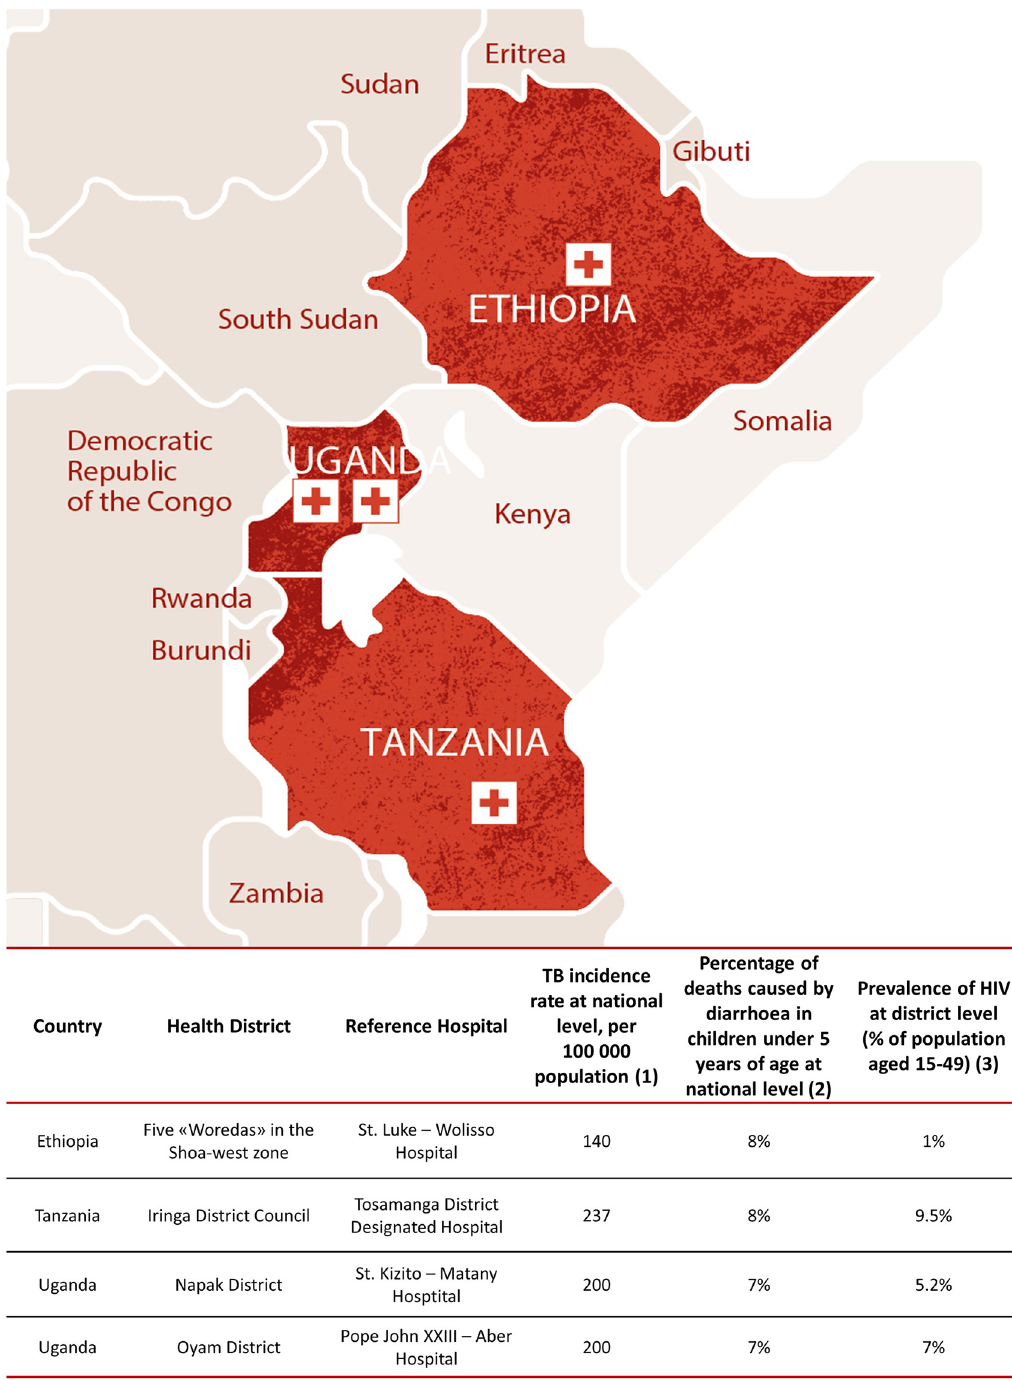
Fig 1. Analysed settings. List of the four analysed hospitals and their respective health districts. Reprinted from Doctors with Africa CUAMM under a CC BY license, with permission from PLOS ONE, original copyright 2021.